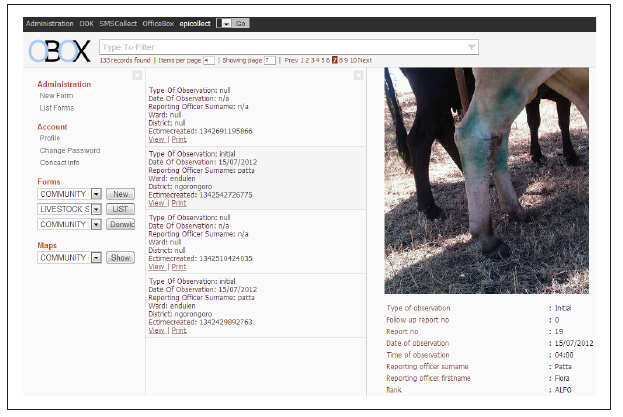
FIGURE 6: The code and question map for mastitis, in addition to the shorthand on how the SMS should be sent to the server.